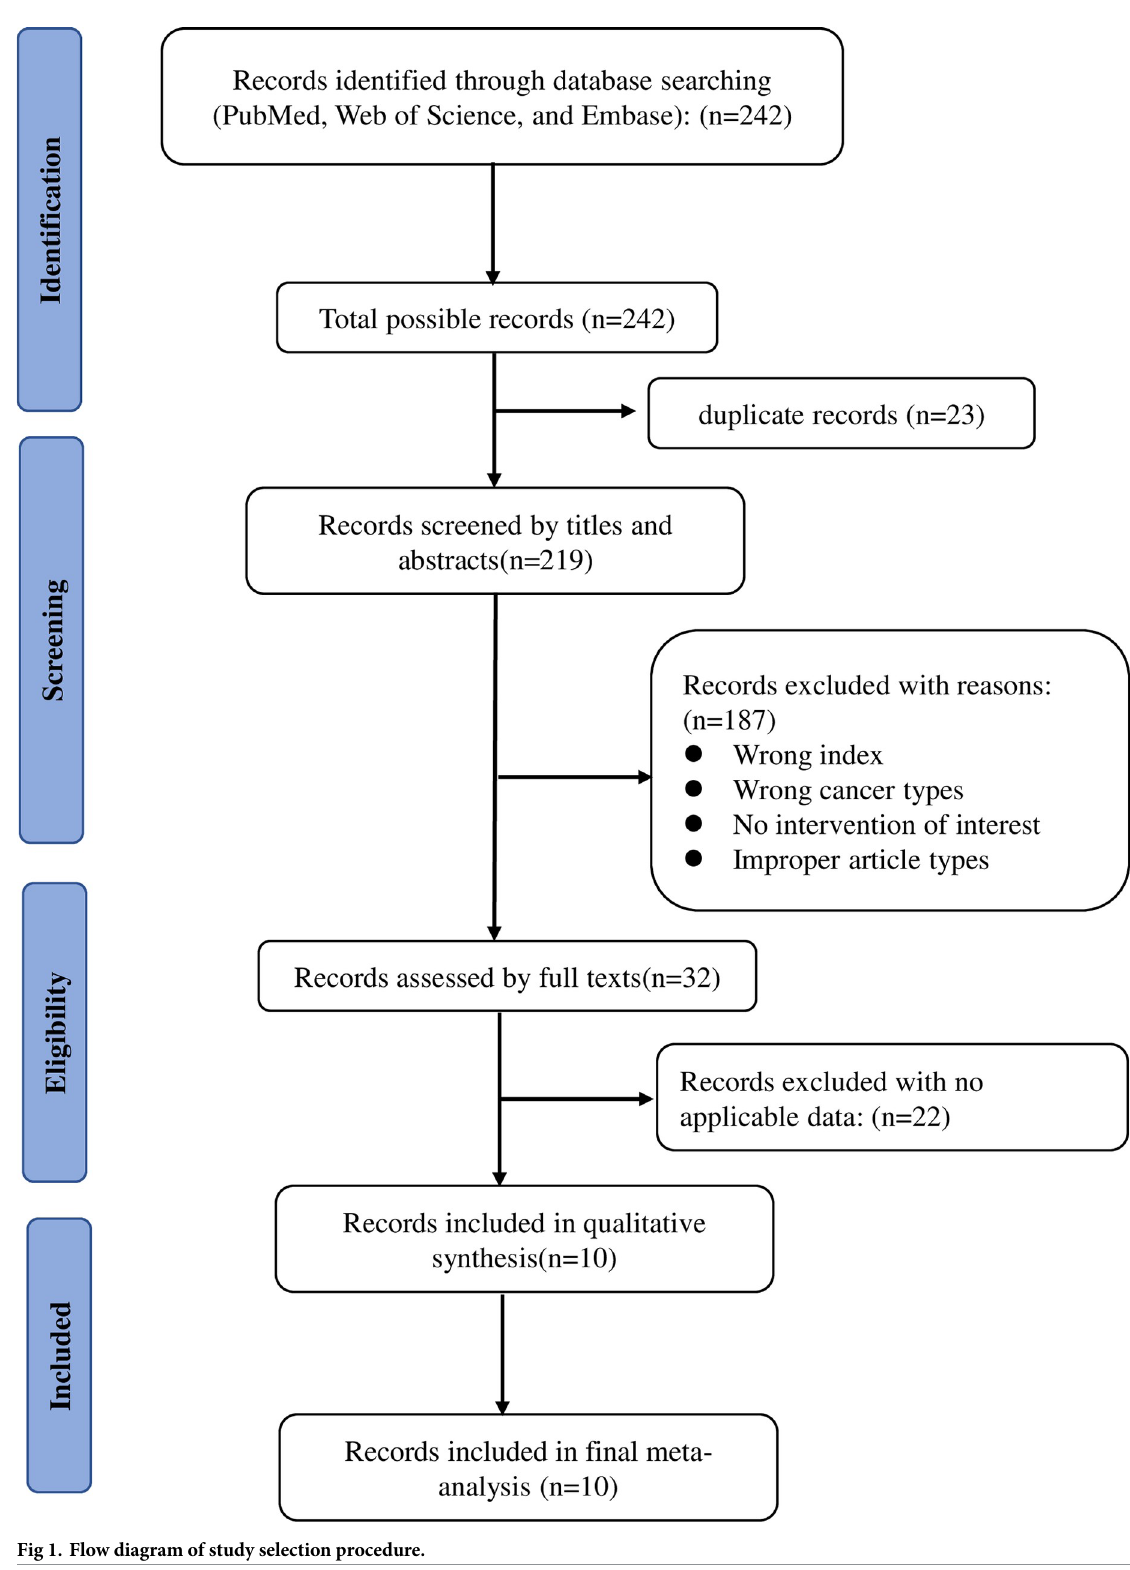
Fig 1. Flow diagram of study selection